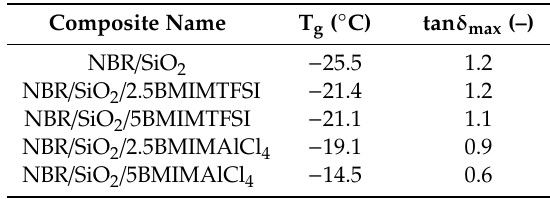
Table 3. Glass transition temperatures and the tan δ peak for NBR / SiO 2 composites containing ionic